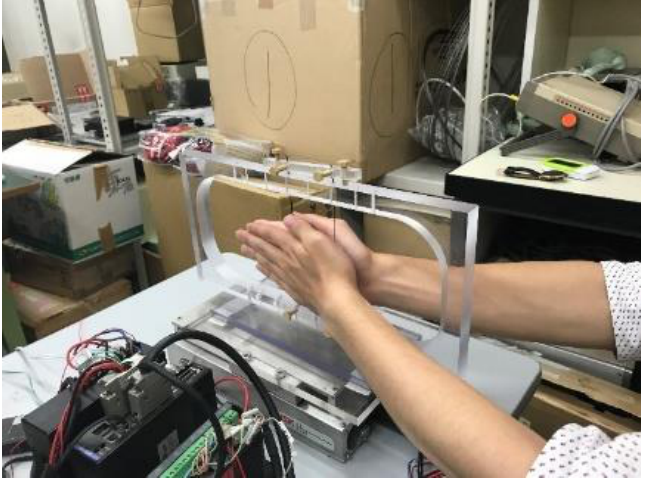
Figure 4. Velvet hand illusion display: two stretched parallel wires are moved in reciprocating manner between palms of hands using stepping motor.